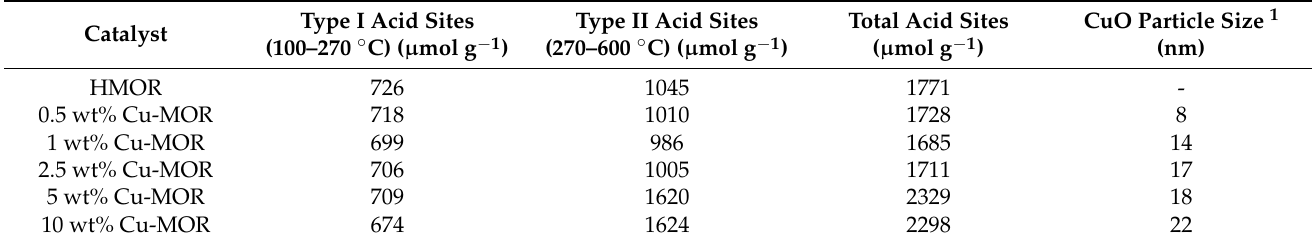
Figure 2. Raman patterns of Cu-MOR catalysts with varying copper loadings.